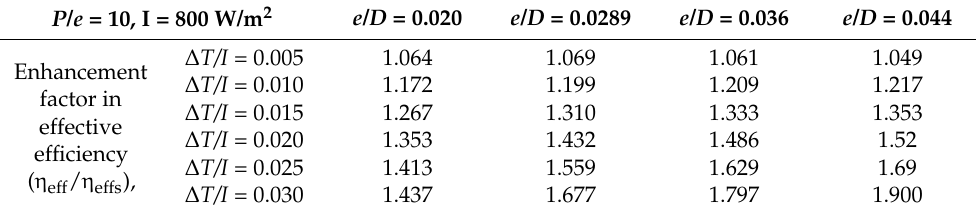
Figure 7. Effect of Reynolds number on effective efficiency. Table 3. Enhancement in effective efficiency at different relative rib